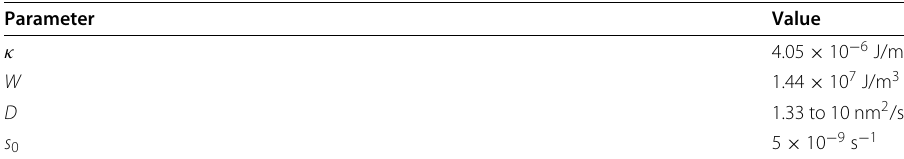
Table 1 Parameters used for phase-field simulations